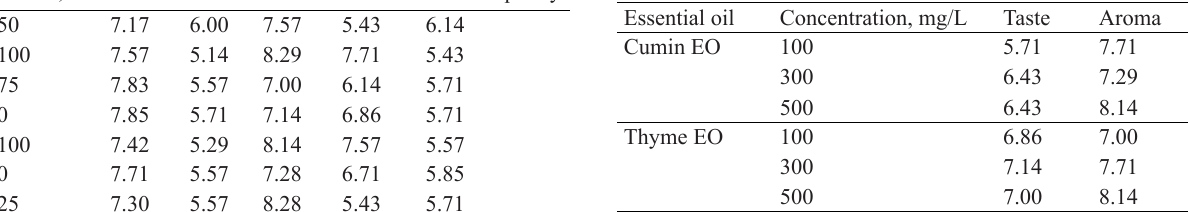
Table 4 Average scores of sensory characteristics of burger samples (surimi percentages predicted by RSM) Surimi, % Colour Taste Aroma Texture Overall quality